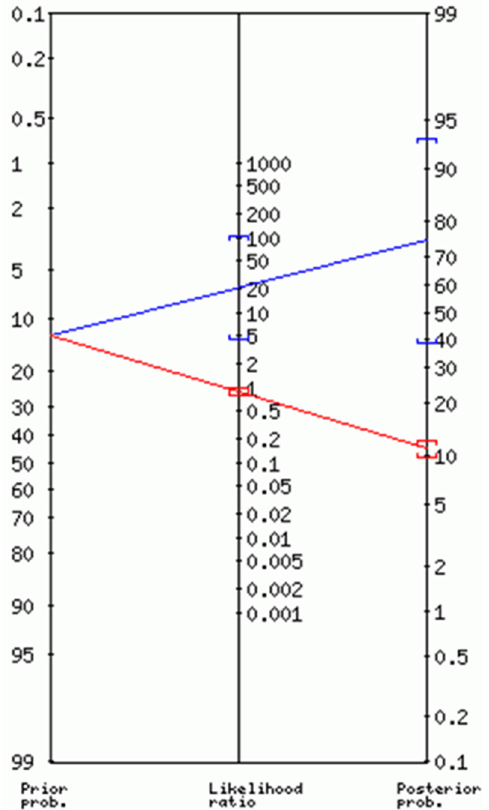
Figure 4. Predictive test of N0 patients in absence of parametrial and lymphovascular invasion. Positive test: blue; Negative test: red; Odds = Probability / (1 − Probability); + LR = Sensitivity / (1 − Specificity); − LR = (1 − Sensitivity) / Specificity; Posterior Odds = Prior Odds ×